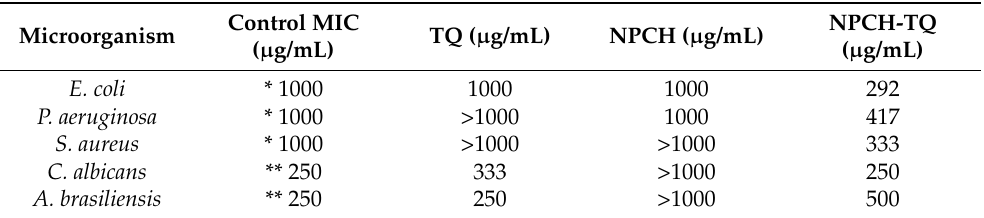
Table 2. Minimum inhibitory concentrations ( µ g/mL) of control drugs (Gentamicin (*) and Tebu- conazole (**)), TQ, NPCH, and NPCH-TQ. Control MIC Microorganism TQ ( µ g/mL) NPCH ( µ g/mL) ( µ g/mL)